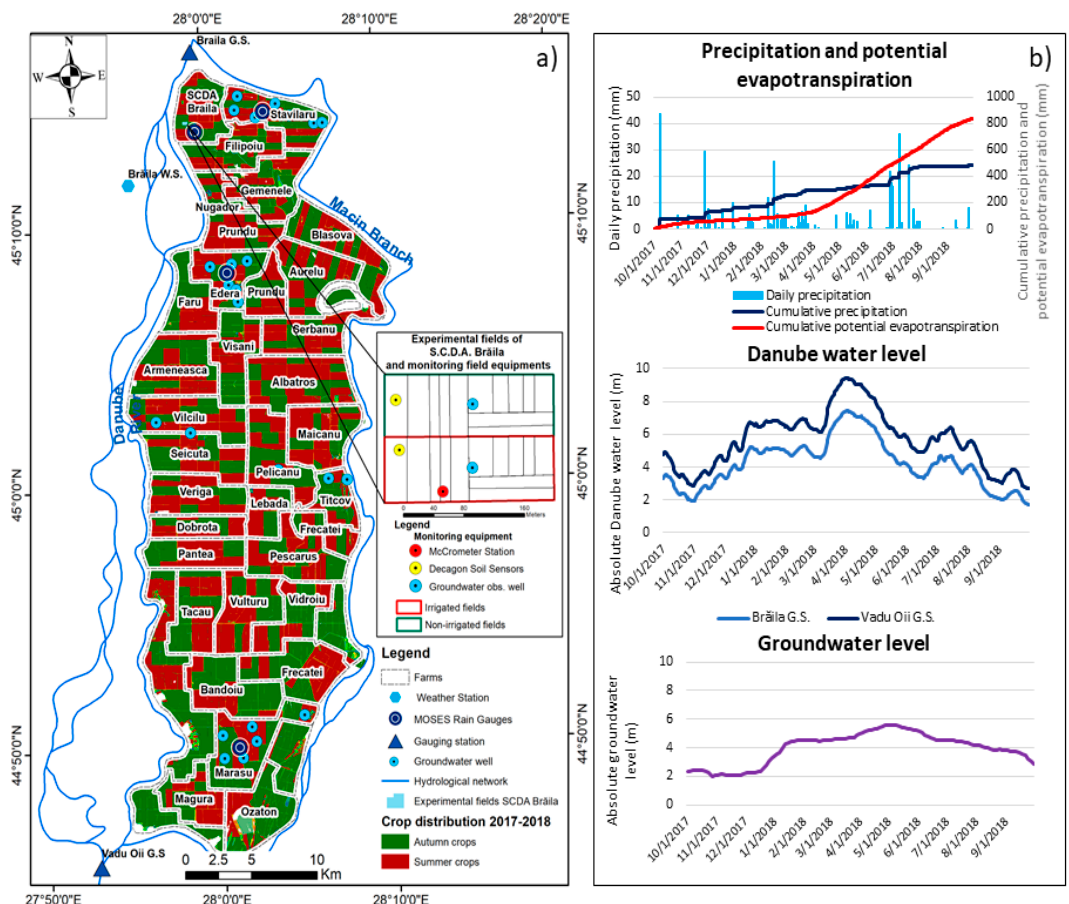
Figure 5. Crop distribution and monitoring equipment ( a ) and the main hydrometeorological parameters ( b ) during the 2017–2018 crop season.